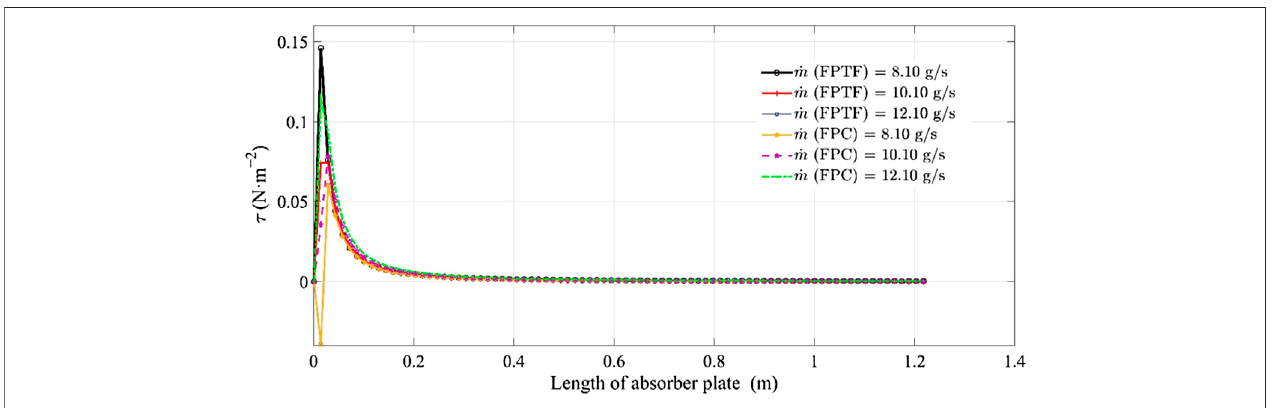
FIGURE 4 | The change in the wall shear stress along the length of the absorber plate.